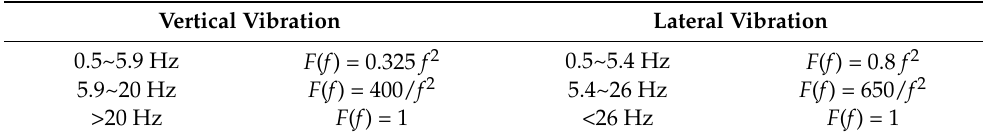
Table 3. The frequency correction factor for high-speed railway vehicles.